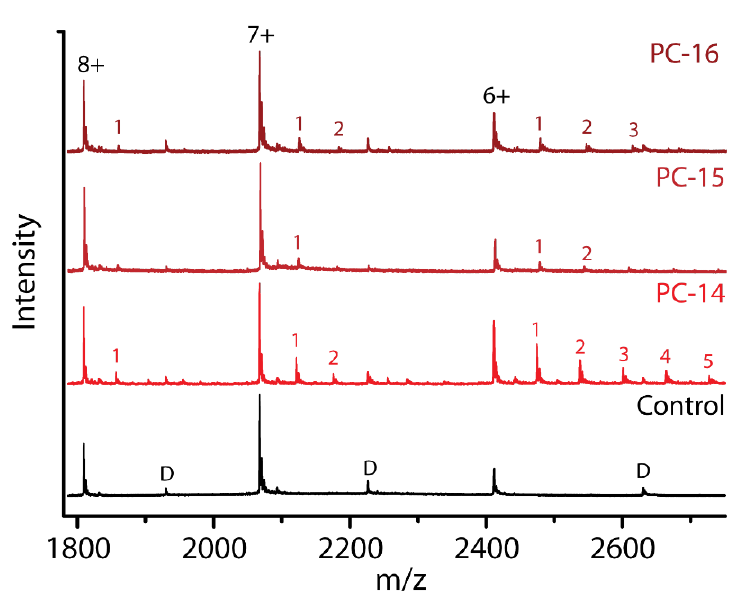
Figure 7. Comparison of fos-choline binding to α-syn. Control, without detergents present, and with PC-14, PC-15 or PC-16 at a concentration of 0.24 mM (2× CMC PC-14, 3.4× CMC PC-15 and 18.5× CMC PC-16)). Dimer peaks are indicated with a ‘D’. Numbers indicate binding stoichiometries of the respective detergent.